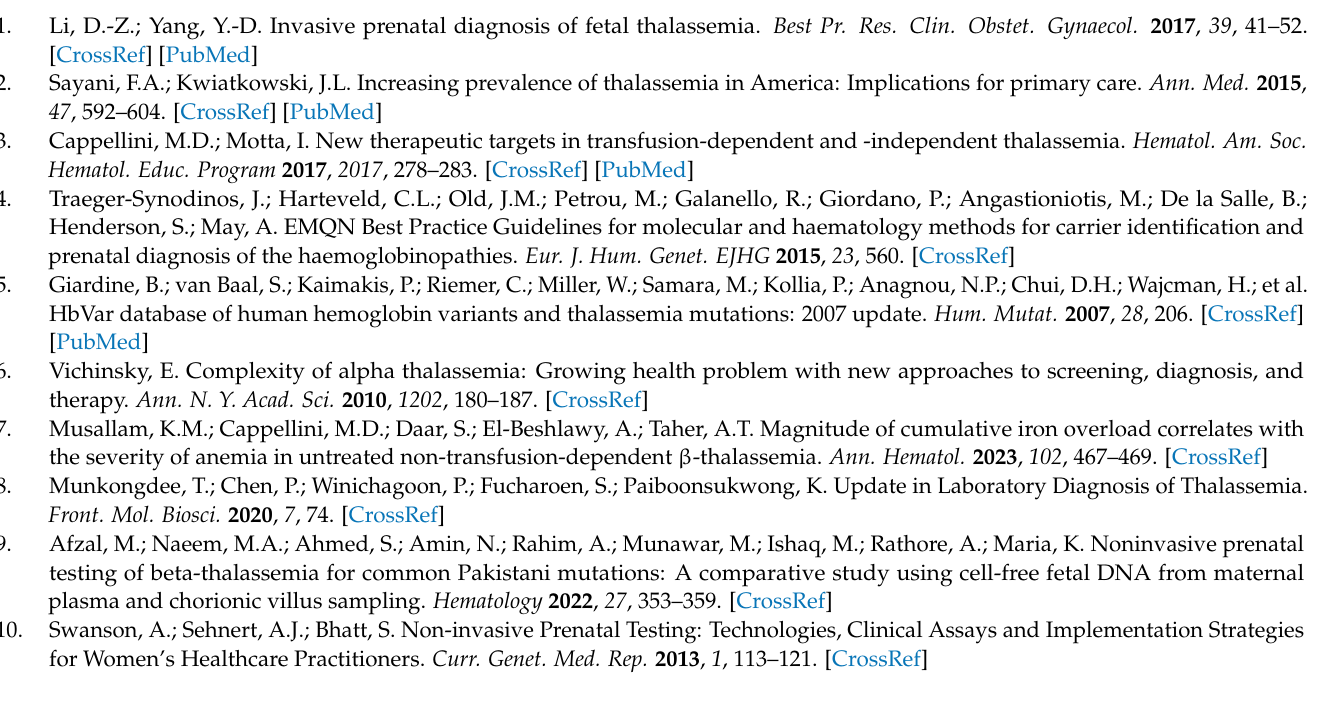
Figure A1. ( a ) (Adult) is the original MRI image of the largest cross section of the liver T2 sequence. ( b ) (Adult) is a sequence image of liver T2 manually segmented by ITK-SNAP. ( c ) (Fetus) is the original MRI image of the largest cross section of the liver T2 sequence. ( d ) (Fetus) is a sequence image of liver T2 manually segmented by ITK-SNAP. Table A1. Results of the Hosmer–Lemeshow tests for different radiomics models.